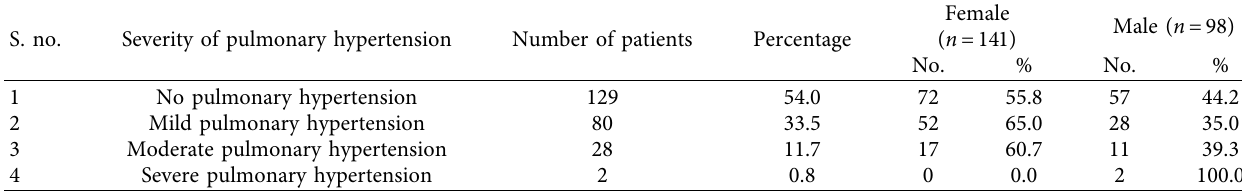
Table 4: Prevalence and severity of pulmonary hypertension (mPAP ≥